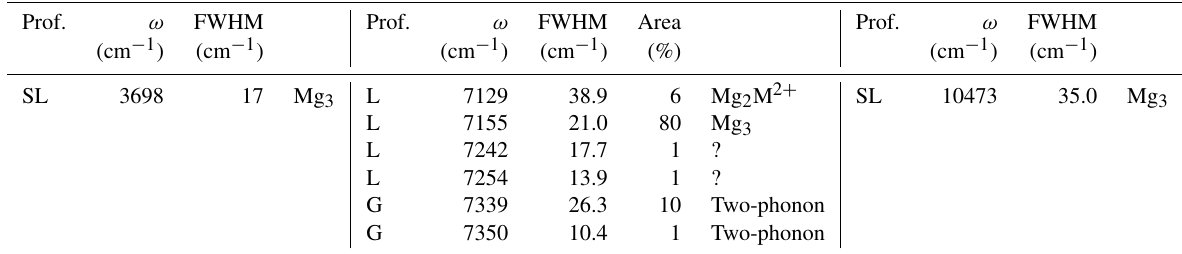
Table 2. Profile function (prof.), frequency ( ω ), full width at half maximum (FWHM) and relative area of bands related to structural OH groups in the MIR and NIR spectra of brucite. Proposed assignments are also indicated in terms of cationic environments (M 2 + = Fe 2 + , Mn 2 + ) or contribution to the two-phonon continuum (two-phonon).